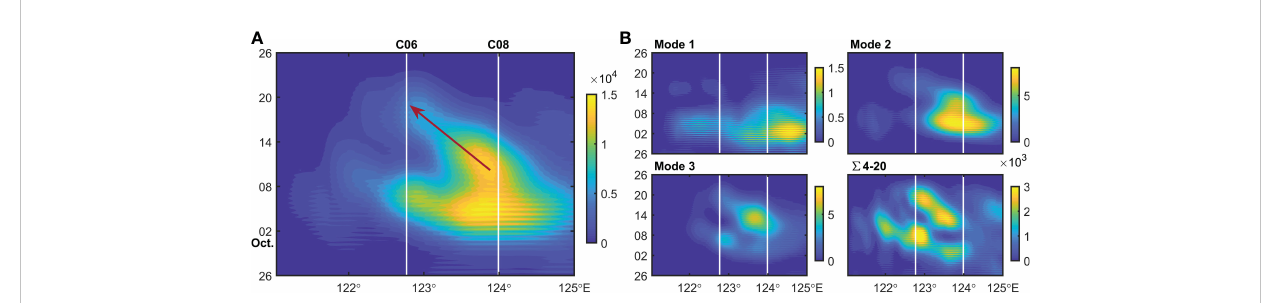
FIGURE 12 Variation of depth-integrated NIKE (unit: J/m 2 ) of total (A) and different modes (B) along 22.4° N. The horizontal axis represents longitude and the vertical axis represents time. The white vertical lines show the longitude of moorings C06 and